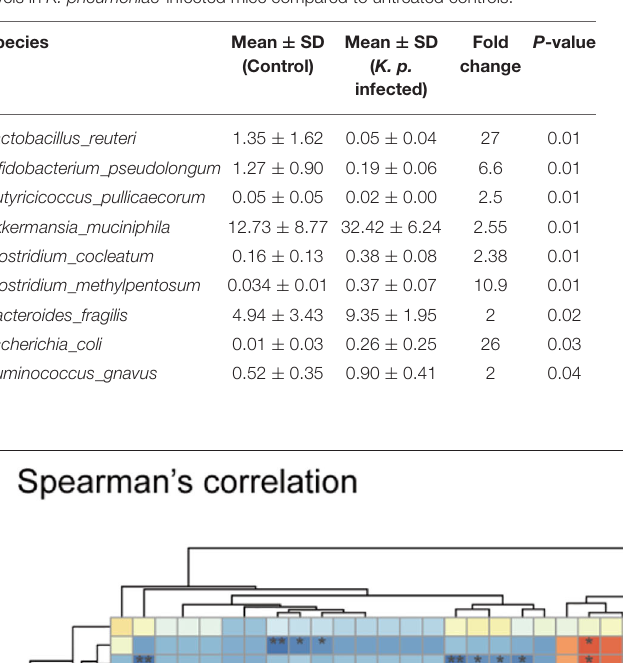
TABLE 1 | Discriminative OTU abundance of taxonomic distributions at species levels in K. pneumoniae -infected mice compared to untreated controls. Species Mean ± SD